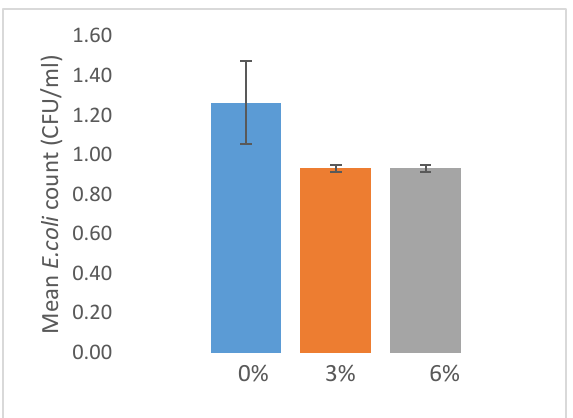
Figure 2. Microbial contamination on fecal matter . Error bars represent ± standard error.